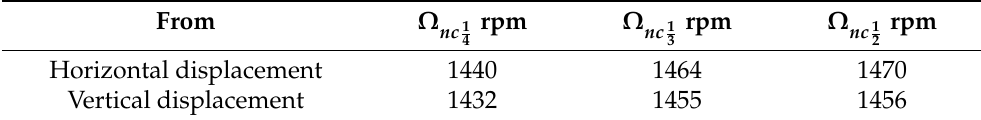
Table 3. Critical speeds for the uncracked shaft obtained at different rotation